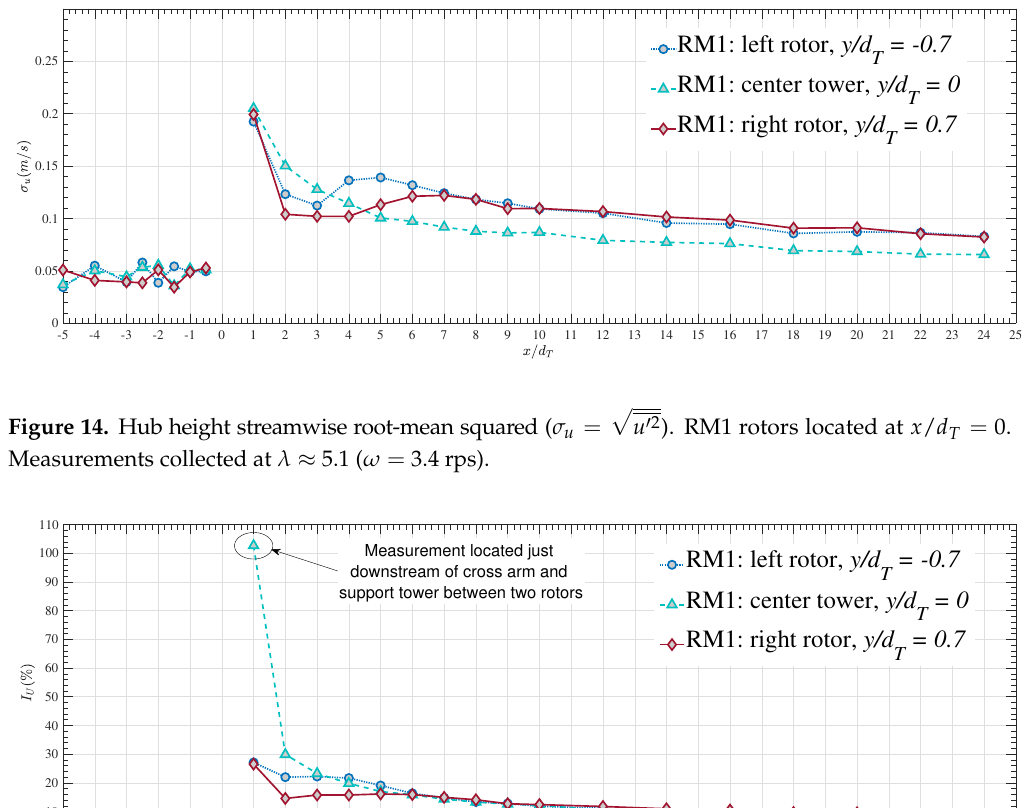
Figure 13. Hub height velocity deficit. RM1 rotors located at x / d T = 0. Measurements collected at λ ≈ 5.1 ( ω = 3.4 rps).